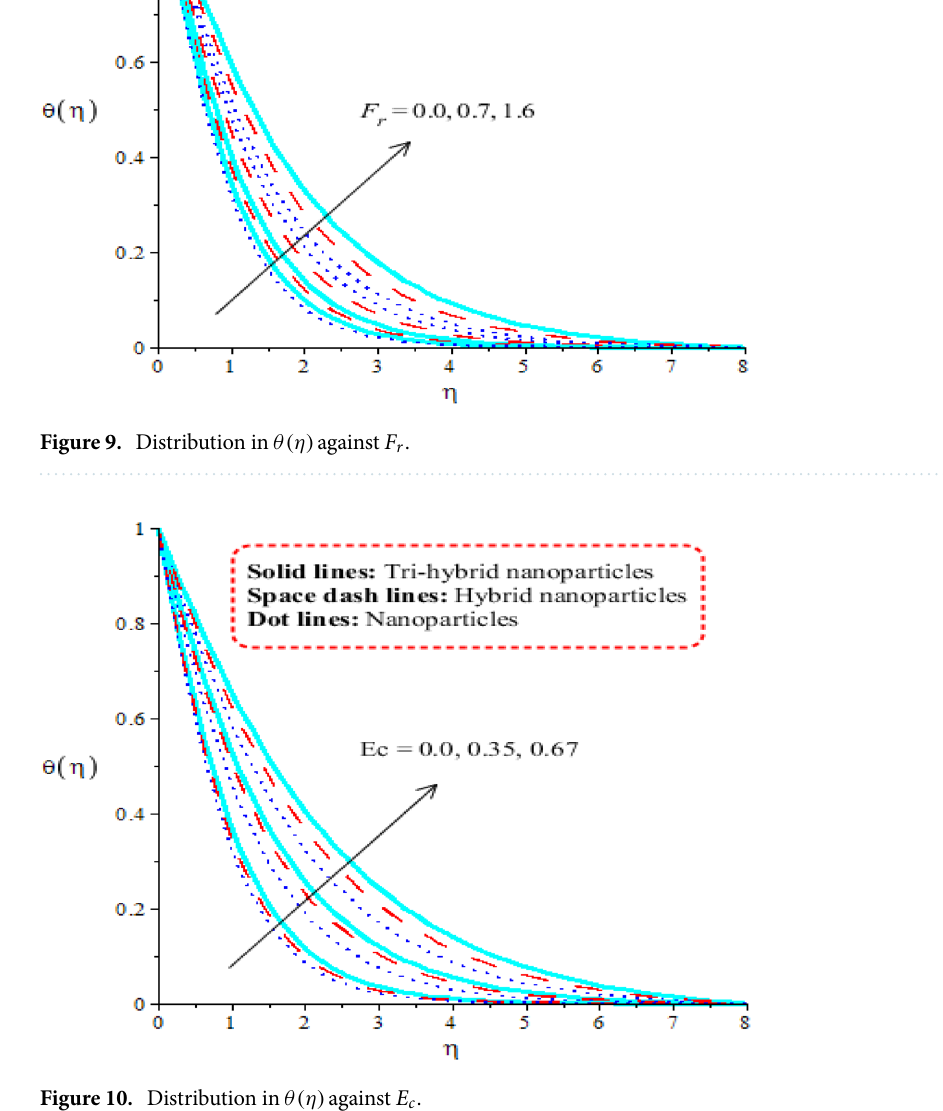
Figure 10. Distribution in θ(η) against E c .